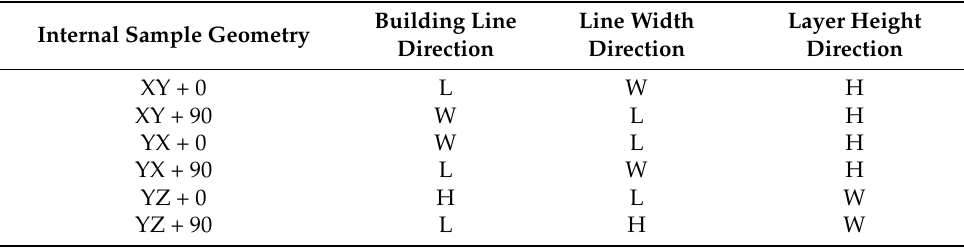
Table 1. Relationship between dimensions of the building lines and the directions of the sample dimensions for each type of internal sample geometry.